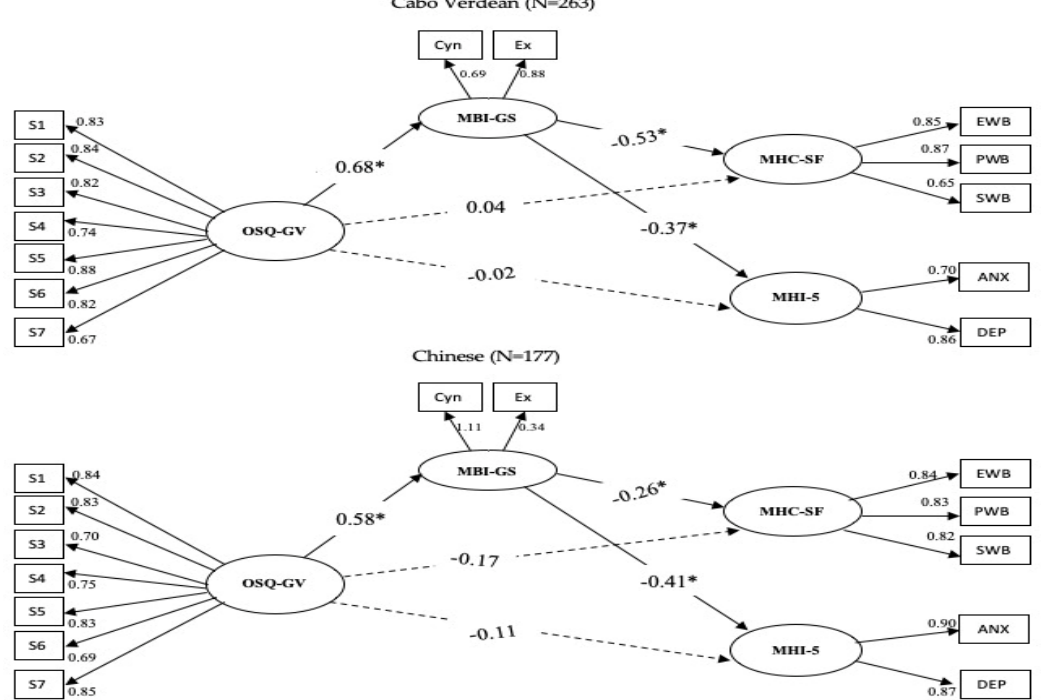
Figure 2. The Mediation model test results. Note. OSQ—GV = S1 to S7 subscales of occupational stress; MBI-GS = (EX = exhaustion–energy, CY = cynicism–involvement); MHC—SF = (PWB = Psychological well-being, EWB = Emotional well-being, SWB = Social well-being); MHI-5 = (DEP = Depression, ANX = Anxiety), (* p < 0.05.).